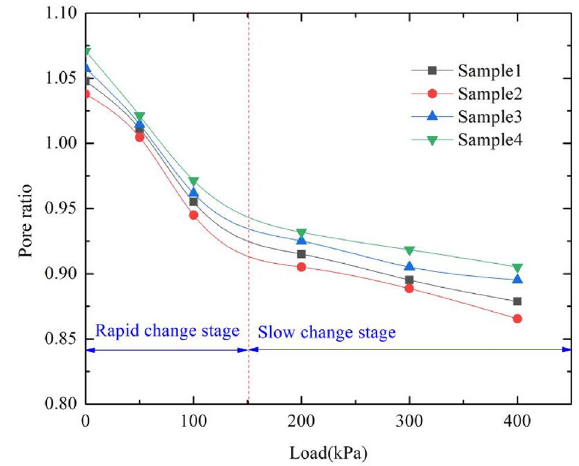
Figure 5. Results of consolidation test.